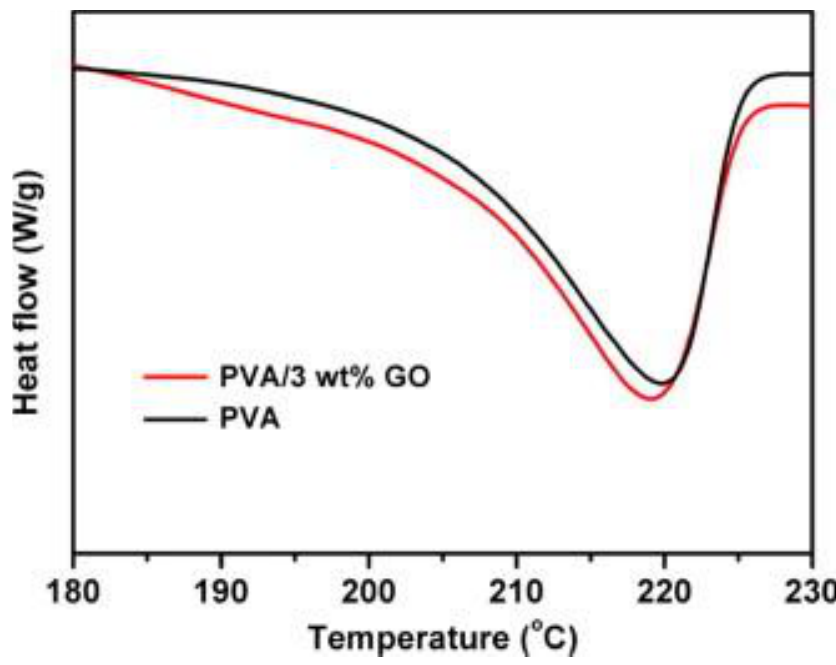
Figure 7. DSC heating curves of PVA/3 wt.% GO composite and neat PVA, endo down [79]. (Adapted with permission from ref. [79]. Copyright 2009 Elsevier.)